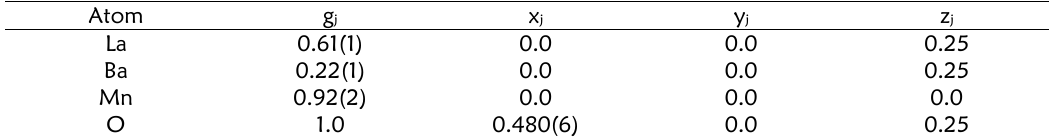
Table 4. The coordinates of atomic fractions (x j , y j , z j ), and atomic occupancy factor (g j ) of S3